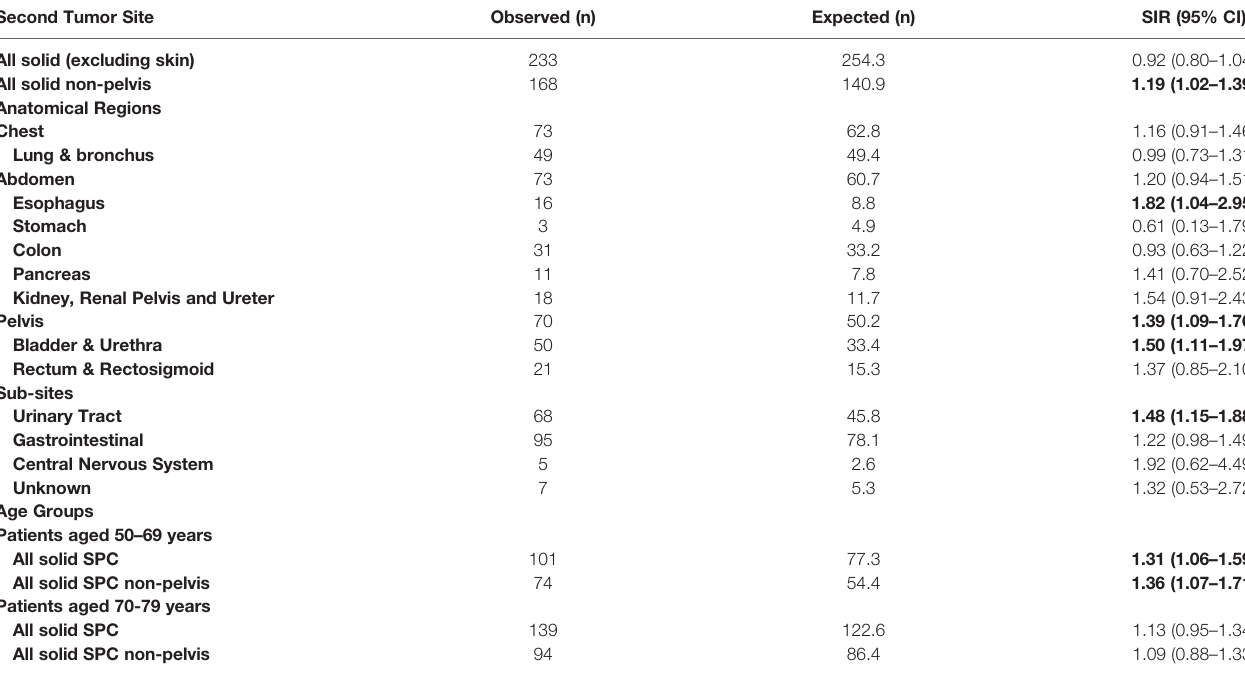
TABLE 2 | Standardized Incidence Ratios (SIRs) for the total cohort compared to the general Dutch male population, adjusted for age and calendar year.